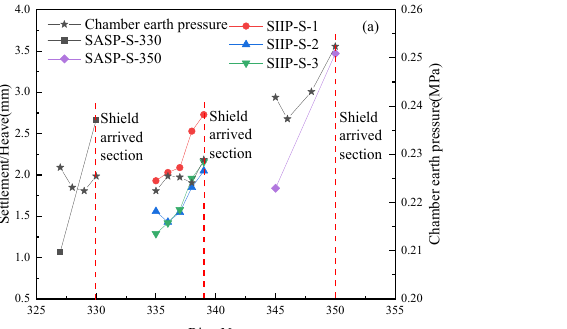
Figure 16. Relationship between thrust force and surface deformation: ( a ) south line; ( b ) north line. As shown in Figure 16a, before the cutter reaches the monitoring section, the surface deformation shows an increasing trend, and the thrust force also shows an increasing trend. When the ring number is 335–339, it increases first and then decreases. This is be- cause the proportion of highly weathered argillaceous siltstone increases, the proportion of round gravel stratum decreases, the friction between soil and shield shell decreases, and the soil still heaves. To ensure small surface deformation, the thrust force needs to reduce. In Figure 16b, ground settlement is observed before the shield cutter reaching the monitoring section, and the thrust force tends to increase to maintain small surface defor- mation. The thrust force of the north line is significantly greater than that of the south line, and the surface deformation is in the state of settlement. Combined with the analysis of crossing stratum, it is found that the proportion of other strata with natural unit weight greater than round gravel stratum in the south line is less than that in the north line, so the static earth pressure of soil in the north line is greater, and the thrust force required for propulsion is also greater.